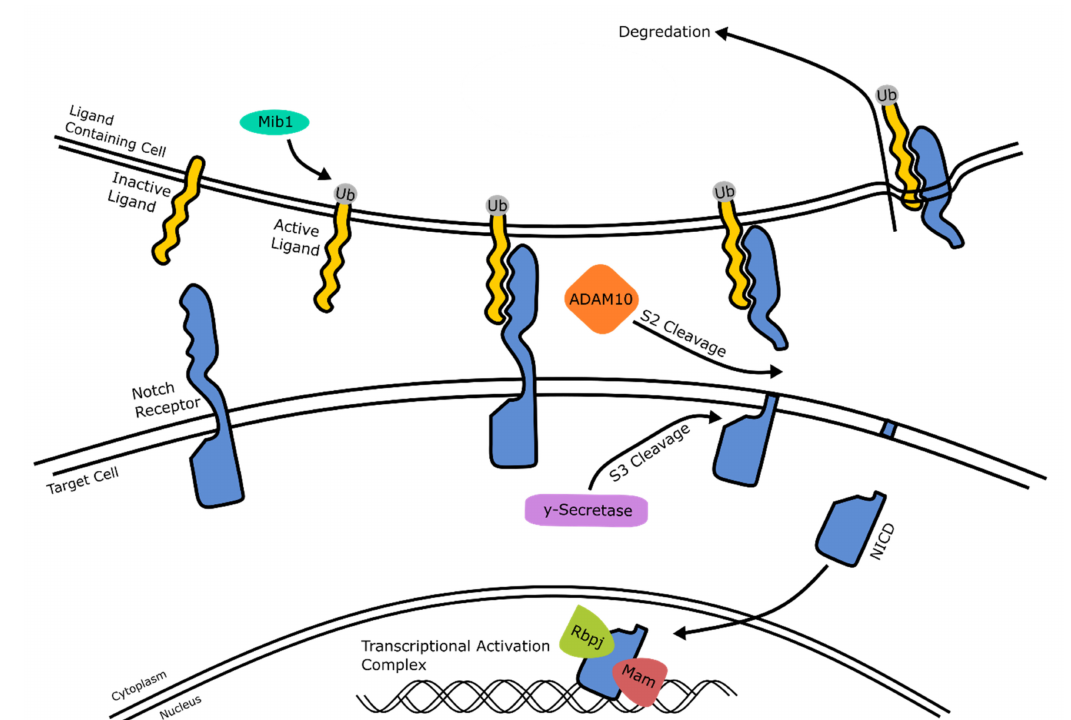
Figure 6. The notch signaling pathway. The multistep notch signaling pathway is presented from left to right in the figure. The first stage of notch signaling occurs in the ligand containing cell ( top ), where inactive ligands are ubiquitinated by Mib1 to become active. The ligands can then bind to a notch receptor present in the target cell membrane ( middle ). This receptor has an extracellular domain and an intracellular domain. The extracellular domain is cleaved by the metalloprotease ADAM10, before being endocytosed by the ligand containing cell. The intracellular domain in the target cell is then cleaved by γ -secretase and transported to the nucleus ( bottom ). Here, it forms a complex with Rbpj and Mam, activating transcription of target genes such as HES1 and HES5